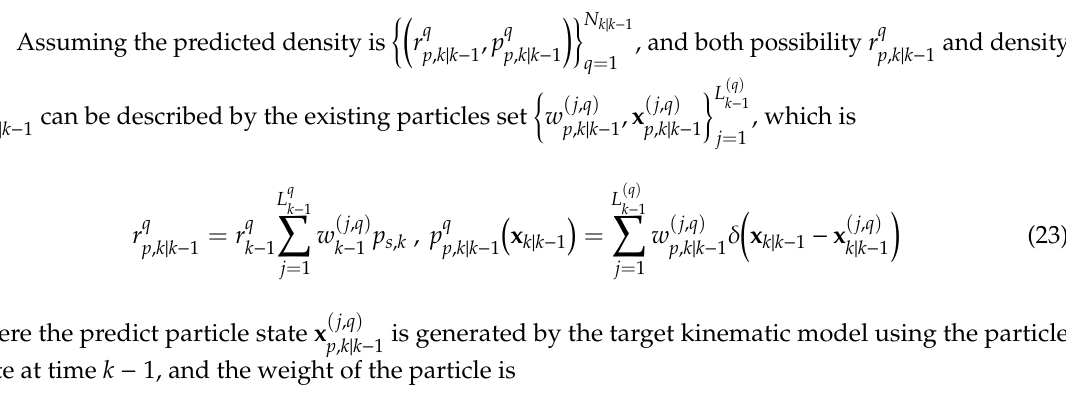
Figure 6. Sequential Monte Carlo (SMC) implementation of the proposed modified ICMB filter.